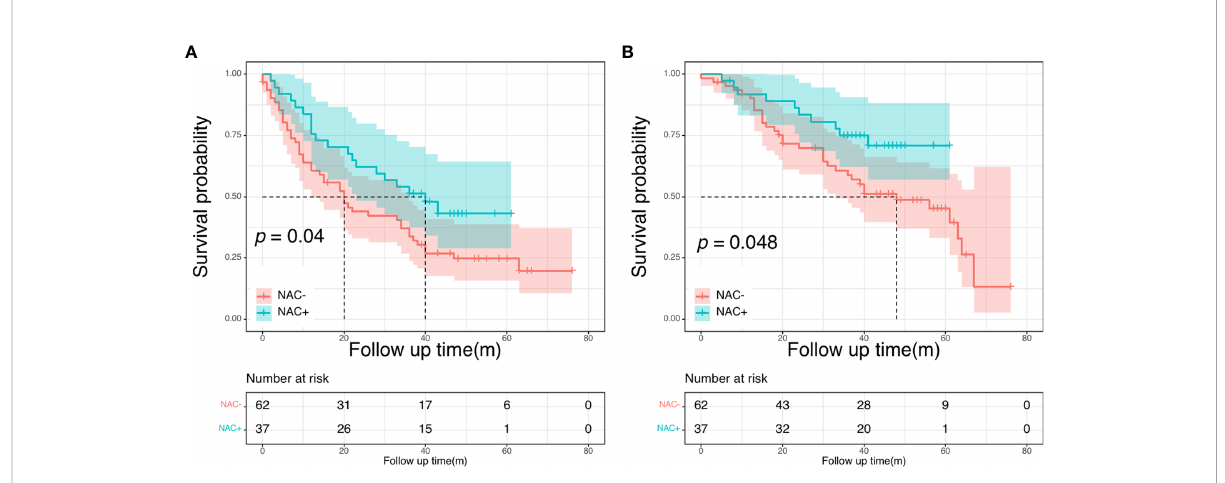
FIGURE 6 Disease-free survival curves (A) and overall survival (B) curves in patients with more than two liver